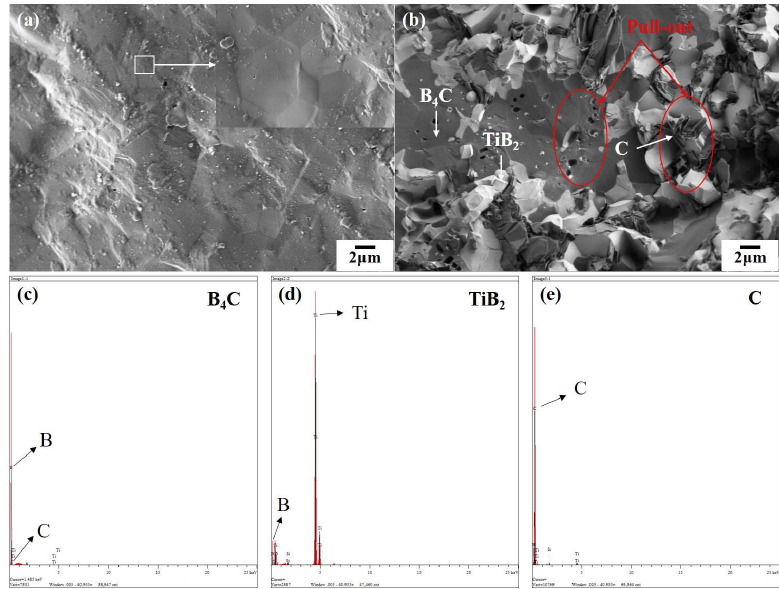
Figure 4. ( a ) SEM image of fracture surface of BT0; ( b ) SEM image of fracture surface of BT30; ( c ) Energy spectrum of B 4 C; ( d ) Energy spectrum of TiB 2 ; ( e ) Energy spectrum of C.